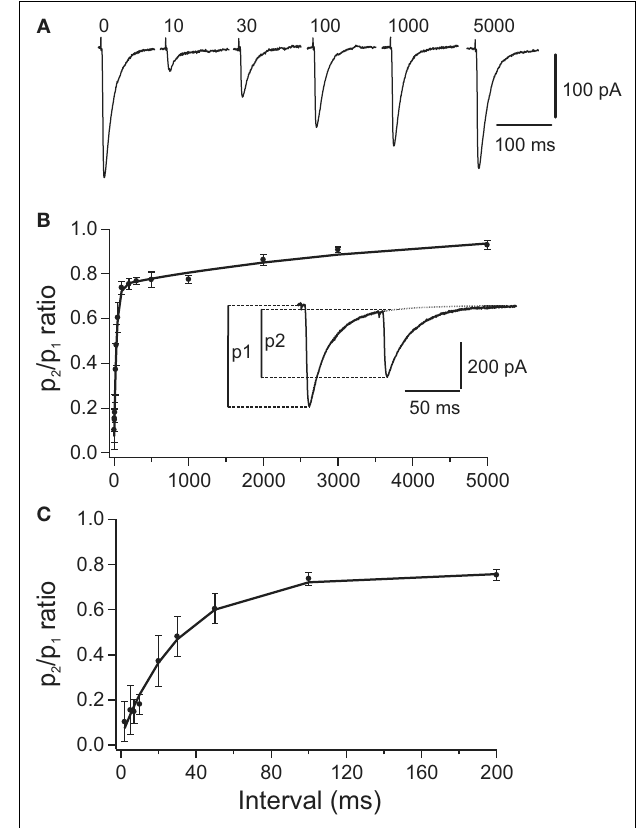
FIGURE 1 | Paired pulse depression (PPD) of compound PC-DCN IPSCs. (A) Representative example of IPSCs evoked by paired stimulation. Each trace illustrates the average of 25 single IPSCs evoked in a DCN by pairs of stimuli with different intervals applied to PC axons. Number above each trace indicates the interpulse interval in milliseconds. Traces corresponding to 10 and 30 ms were obtained after subtracting the response to the 1st stimulus (labeled with “0”). (B,C) Time course of recovery from PPD shown at two different time scales. Average peak amplitude ratio (p2/p1) was plotted against the interpulse interval ( n = 24). The curves represent a double exponential expression fi tted to the data. The peak amplitude of IPSCs was measured from the baseline to the peak of the respective IPSCs. Taken with permission from Pedroarena and Schwarz